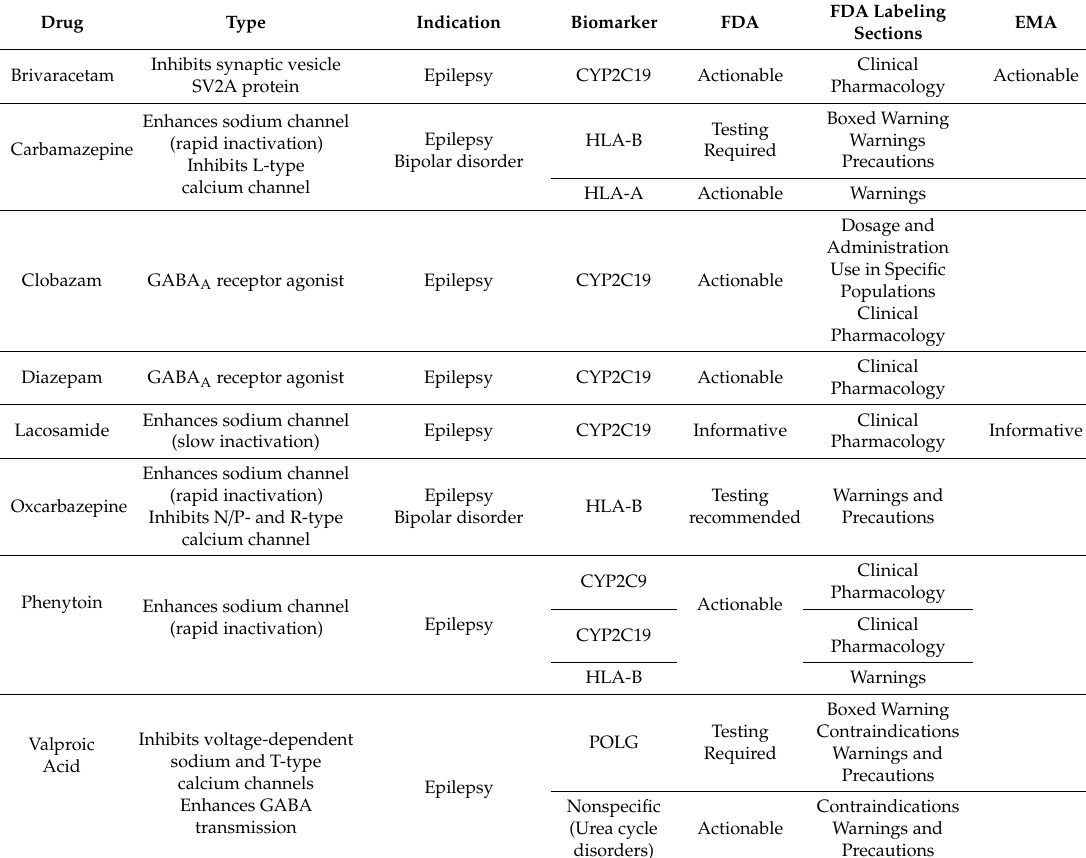
Table 2. FDA pharmacogenomic biomarkers in drug labeling in